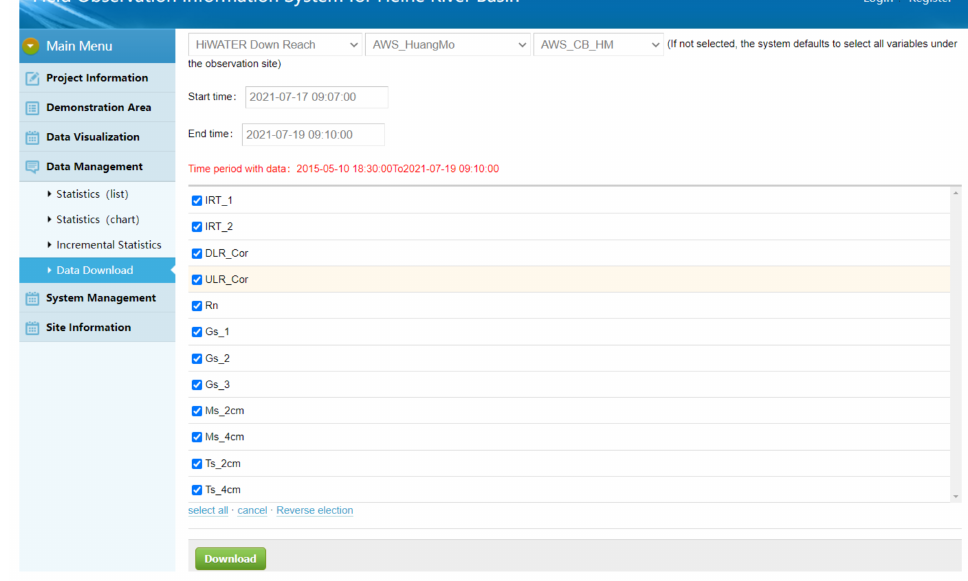
Figure 11. Data downloading interface (translated from the user interface in Chinese).